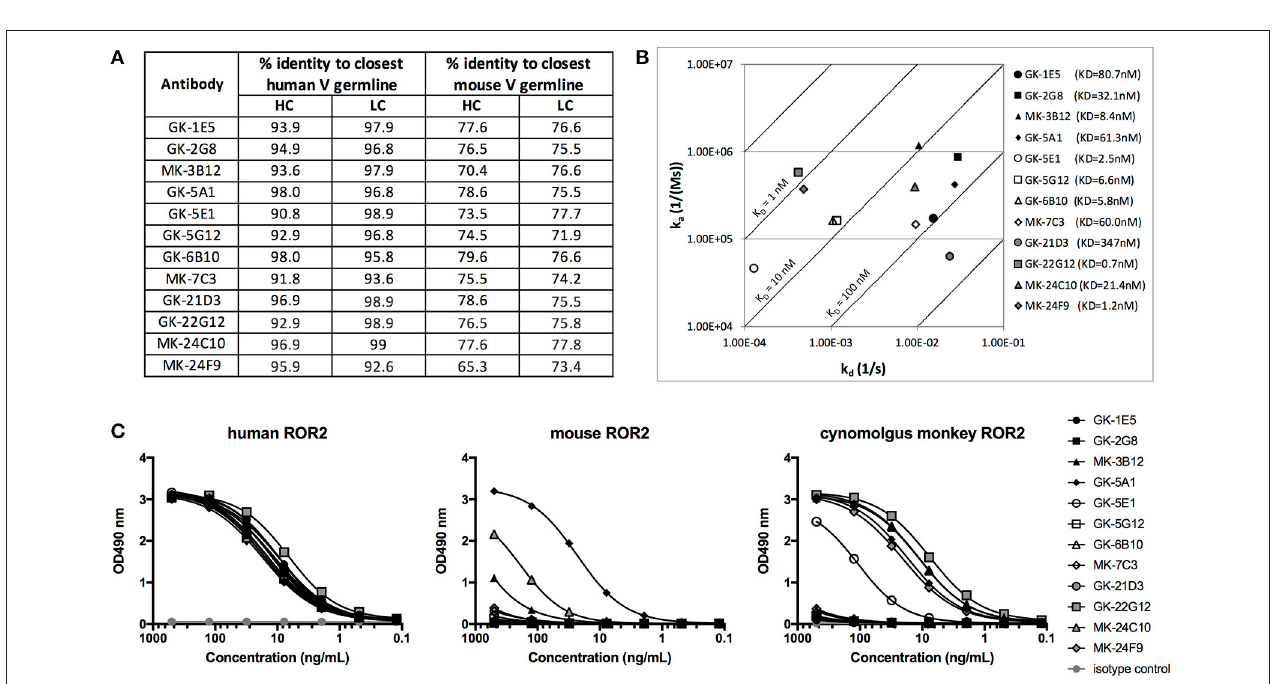
FIGURE 5 | Alignment of amino acid sequences of identified hROR2-specific antibodies. Heavy chain and Kappa light chain variable regions were PCR amplified from single-cell L11 clones by reverse transcription and subjected to Sanger sequencing. The derived amino acid sequences of recovered V H (A) and V κ (B) are shown. Antibodies were annotated using IgBLAST. FR, framework region; CDR, complementarity-determining region. Dashes indicate gaps due to the alignment.